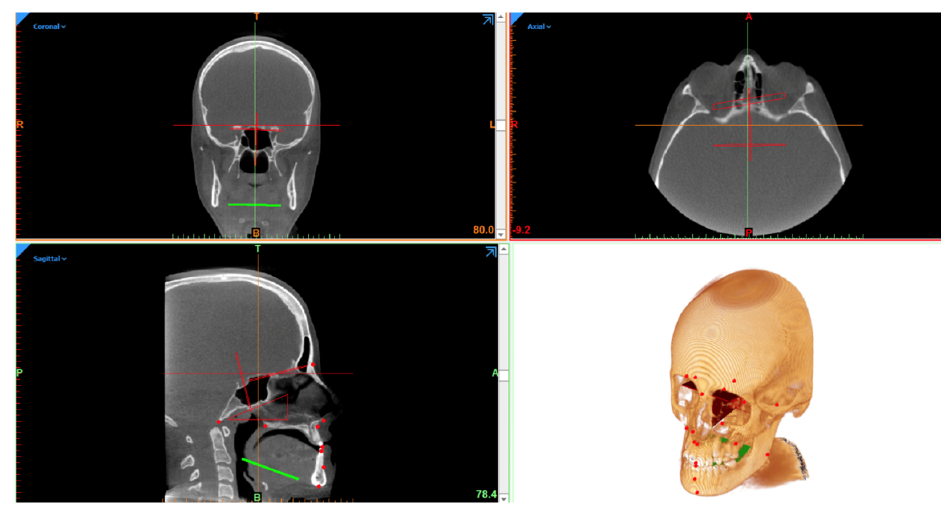
Figure 1. Figure representing the full 3D cephalometry multi-planar vision and three-dimensional reconstruction.